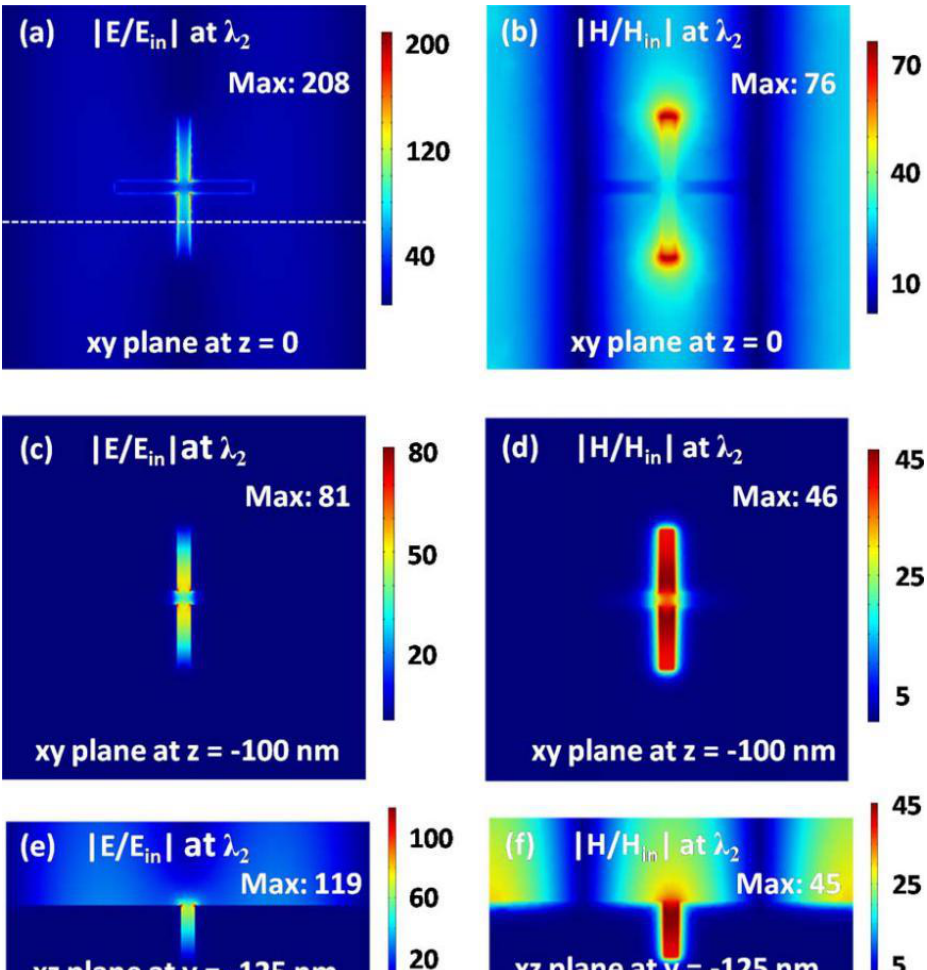
Figure 6. Electric ( a , c , e ) and magnetic ( b , d , f ) field strength at the resonance wavelength of λ 2 . The xy plane with z = 0 ( a , b ) is just on the top surface of the metal substrate. The xy plane with z = −100 nm ( c , d ) is at the geometrical center of the cross-shaped hole. The xz plane with y = −125 nm ( e , f ) is along the white dotted line in ( a ).